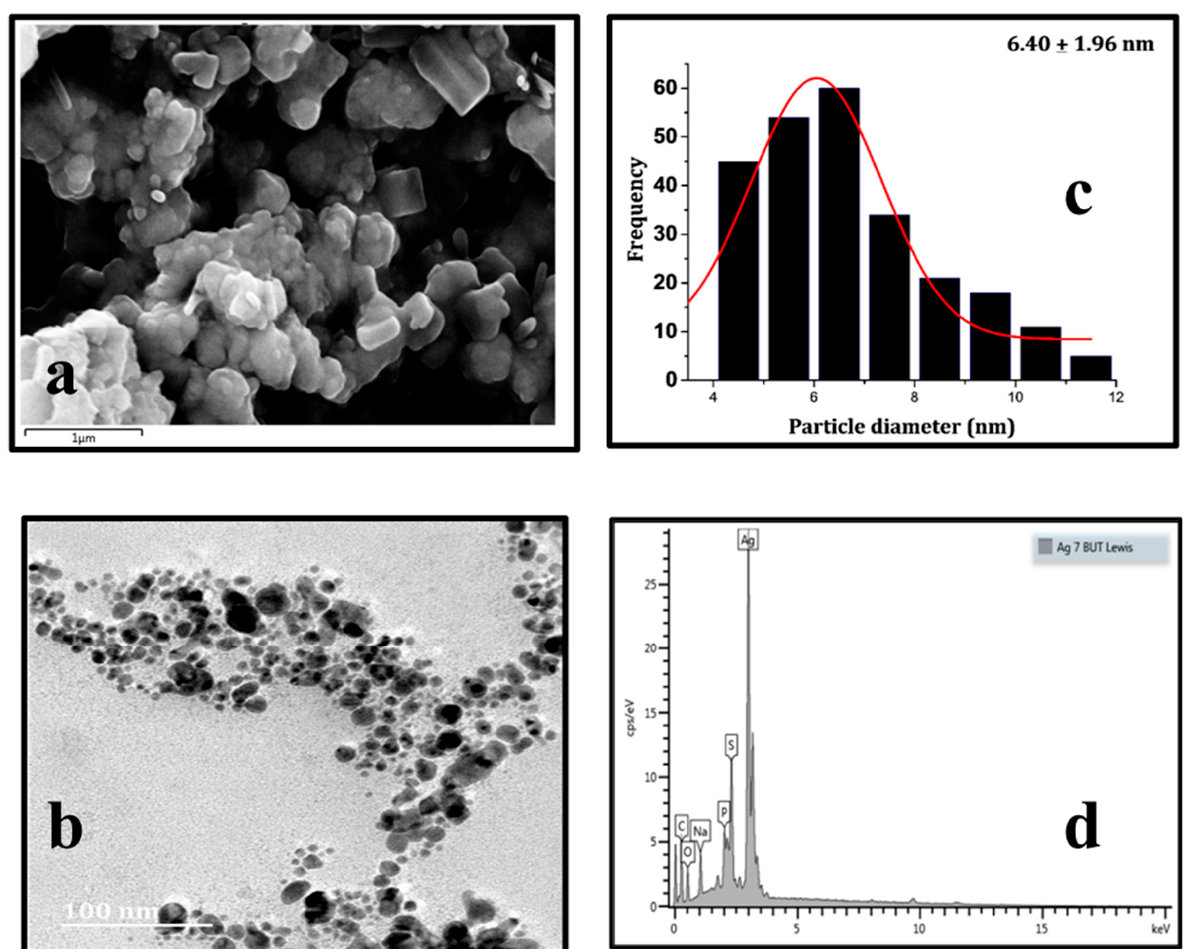
Figure 4. ( a ) SEM micrographs of AgNPs. ( b ) TEM micrographs of AgNPs. ( c ) Particle size distribu- tion of AgNPs. ( d ) EDX spectrum of AgNPs.